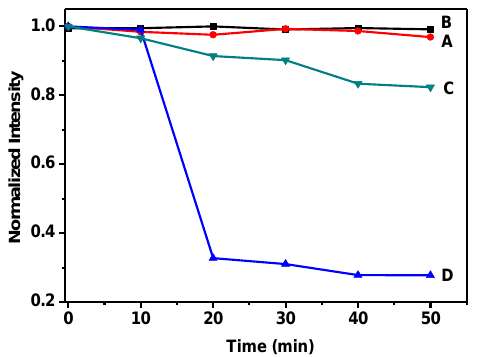
Figure 4. Photostability of the polysaccharide-based NSs prepared from starch ( A ) and chitosan ( B ), as compared with rhodamine B ( C ) and fluorescein ( D ).